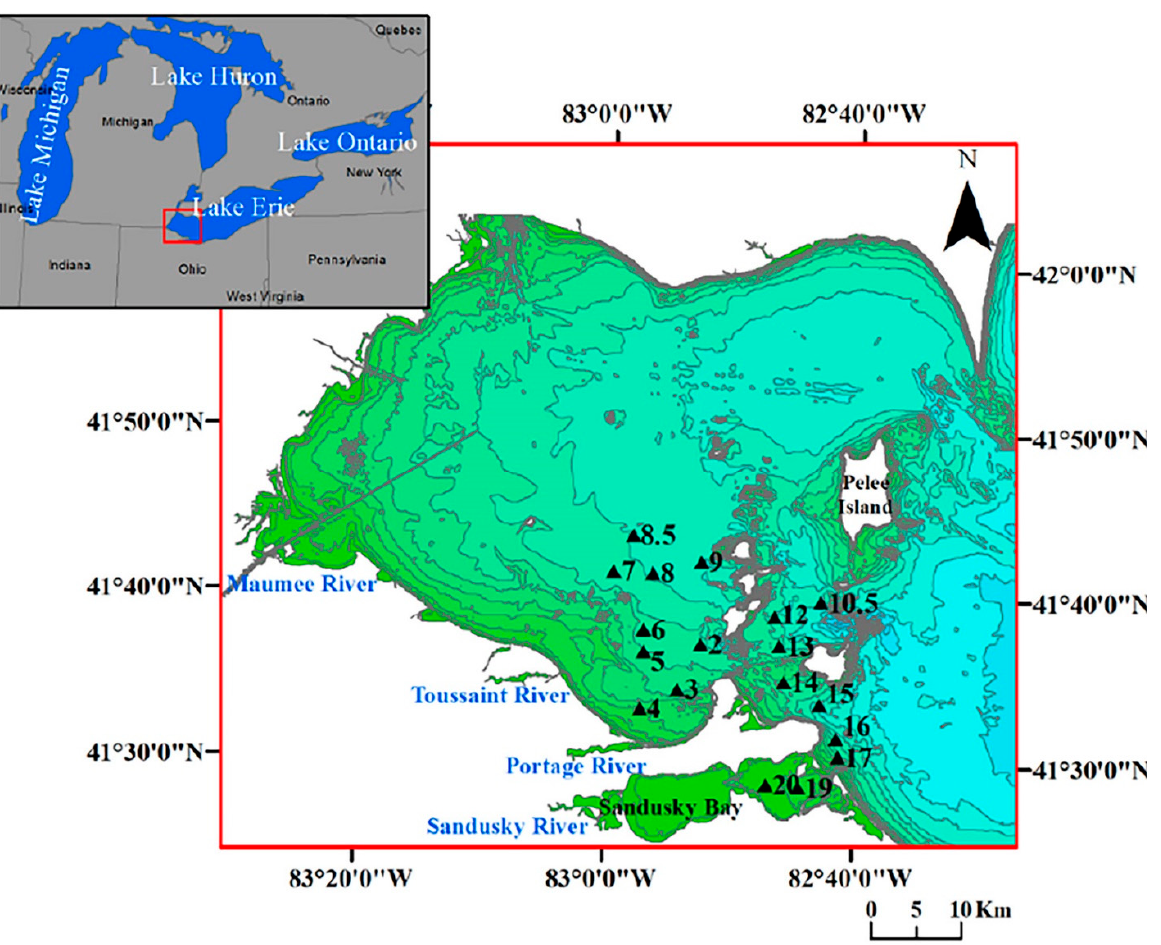
Figure 1. Sampling locations in the western basin of Lake Erie (after [3]).